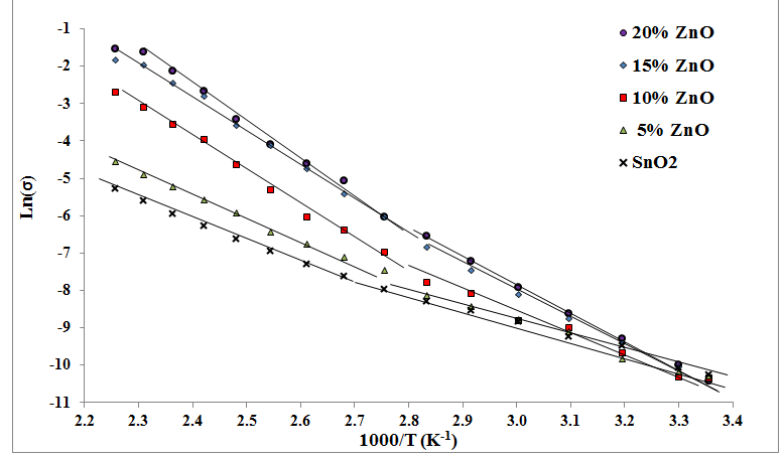
Fig. 2: Electrical conductivity logarithm with reciprocal temperature for (SnO